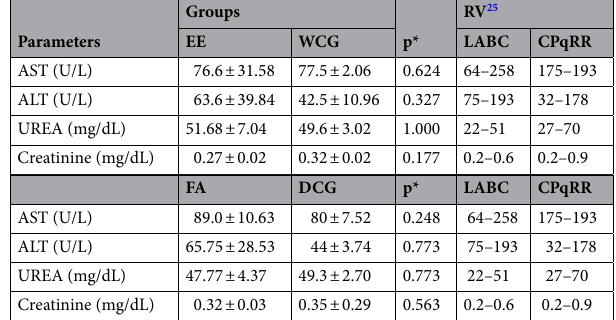
Table 8. Biochemical parameters of mice treated orally with ethanolic extract or alkaloid fraction from Aspidosperma nitidum for 28 days. EE ethanolic extract, FA fraction of alkaloids, WCG water control group, DCG DMSO control group (99% water + 1% DMSO), AST aspartate aminotransferase, ALT alanine aminotransferase, RV reference value, LABC Laboratory Animal Breeding Center, CPqRR René Rachou Research Center. * p value was obtained by Student’s T-test, comparing EE versus WCG, or FA versus DCG.